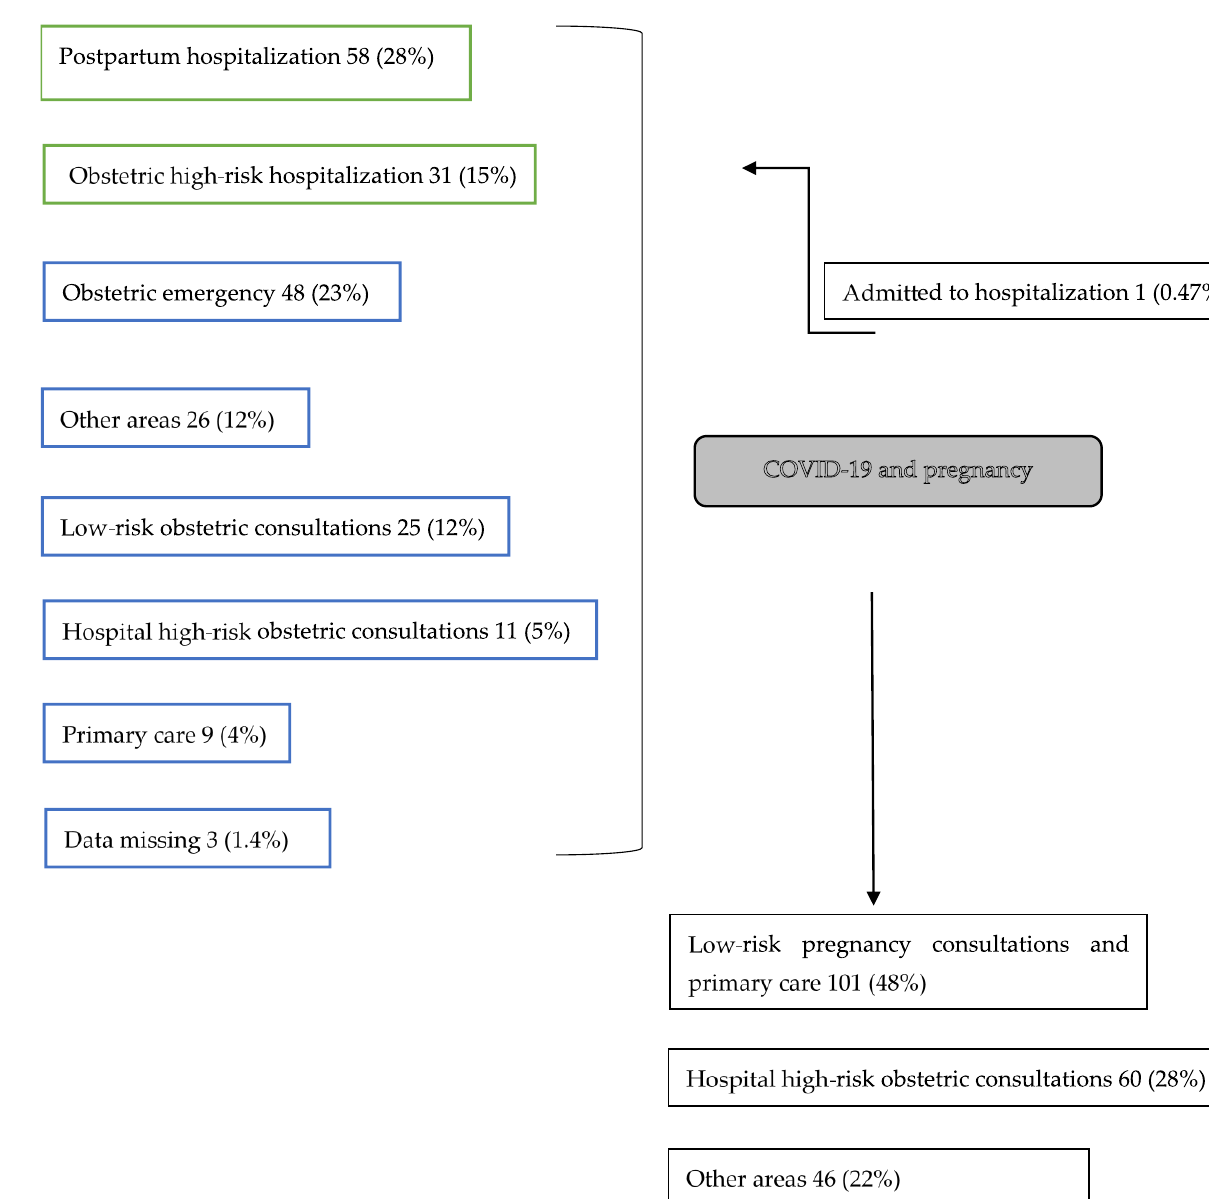
Figure 1. Patient flux: Recruitment from reference areas (green: inpatient, blue: outpatient) to COVID-19 and pregnancy program and discharge.